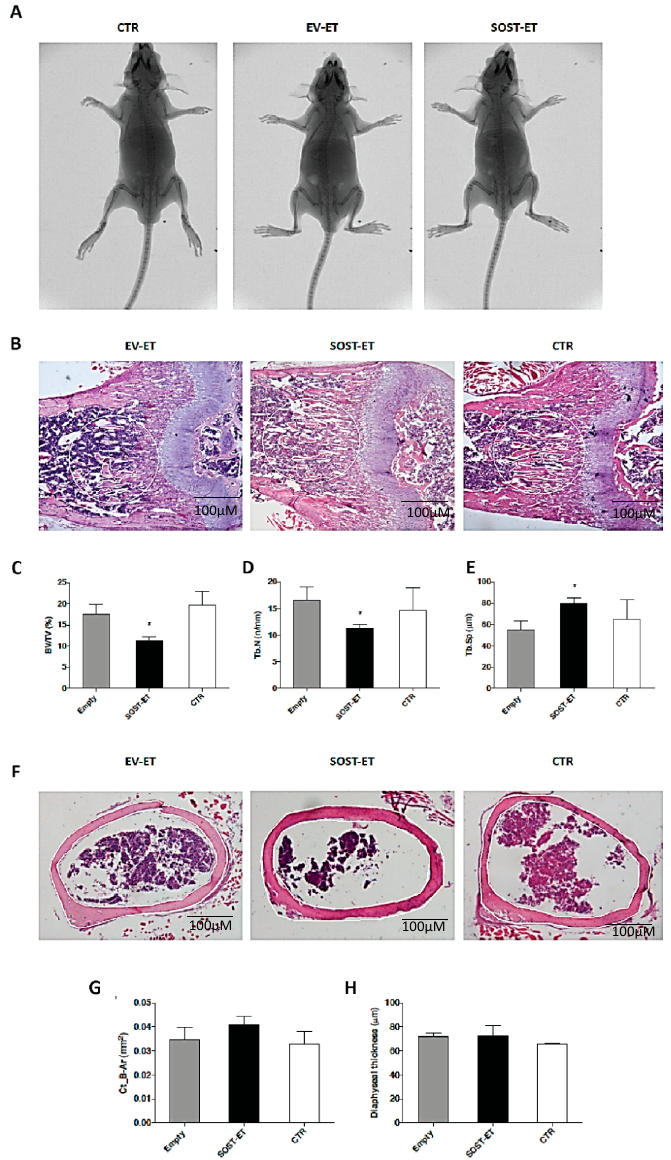
Figure 6. ( A ) Representative X-ray scans of the skeleton of each mice group: CTR, EV-ET, SOST-ET. ( B ) Sagittal section of the distal third of femur (4× magnification). Exemplificative histological sections (5 mm) of femurs of non-electroporated (CTR), empty vector (EV-ET), and SOST-vector electroporated animals in which the histomorphometric analyses were performed. ( C – E ) Mean values of histomorphometric parameters expressed as BV/TV (%), Tb.N (n/mm), Tb.Sp (mm) in trabecular bone of the three animal groups. ( F ) transversal section at the mid-diaphyseal level of femur (10X magnification). The white line indicates the areas in which histomorphometric evaluations were recorded. ( G , H ) Mean values of histomorphometric parameters expressed as CT_B-Ar (mm 2 ) and diaphyseal thickness (mm) in cortical bone of the three animal groups. Values are expressed as the means ± SEM. * p <